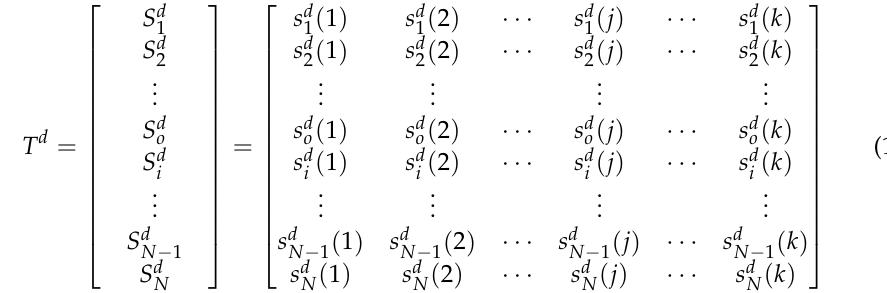
Figure 1. BILSTM structure diagram .